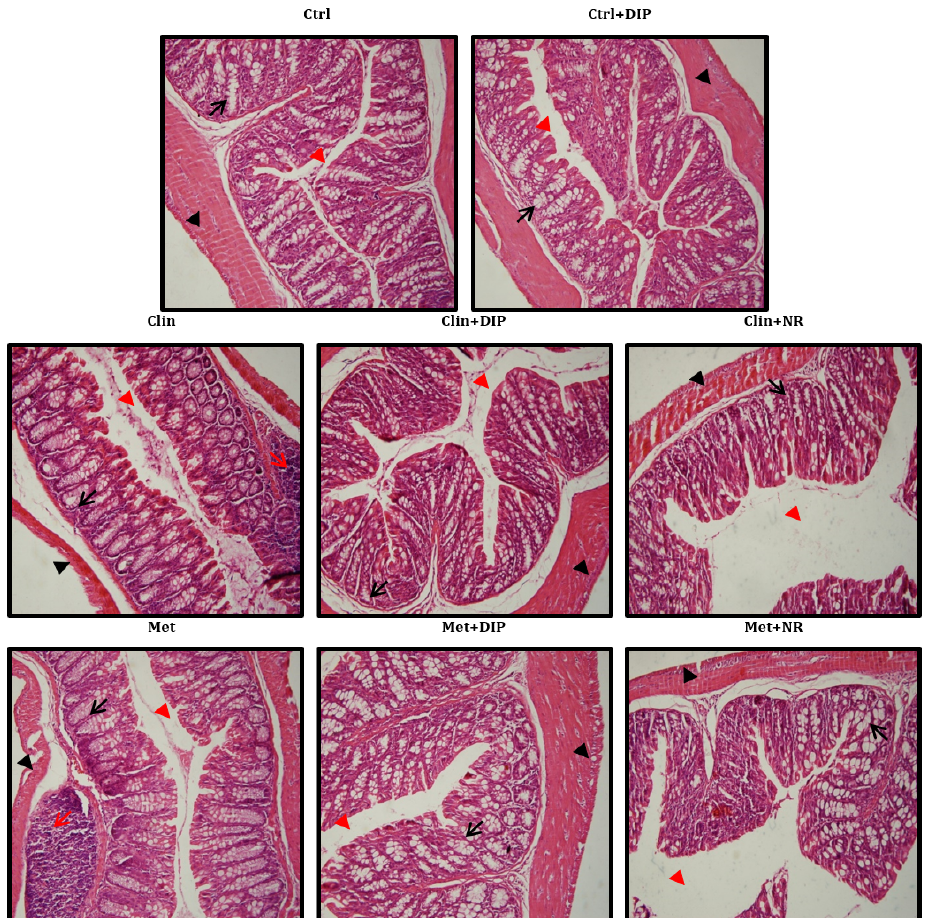
Figure 6. Effect of DIP on colonic histological alterations in antibiotic-induced dysbiosis mice. Photomicrographs of hematoxylin and eosin (H&E)-stained distal colon sections. Shown are inflammatory cells (indicated with red arrows), the mucosal space (red arrow head), goblet and epithelial cells (black arrows), and the epithelium surface (black arrow head). Original magnification × 20, Scale bar: 100 μ m.